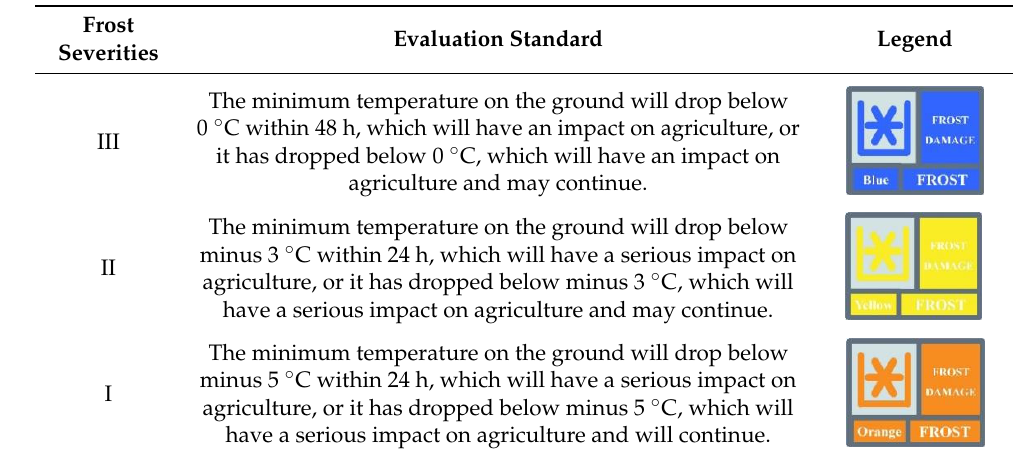
Table 1. Meteorological frost severities and its standard.